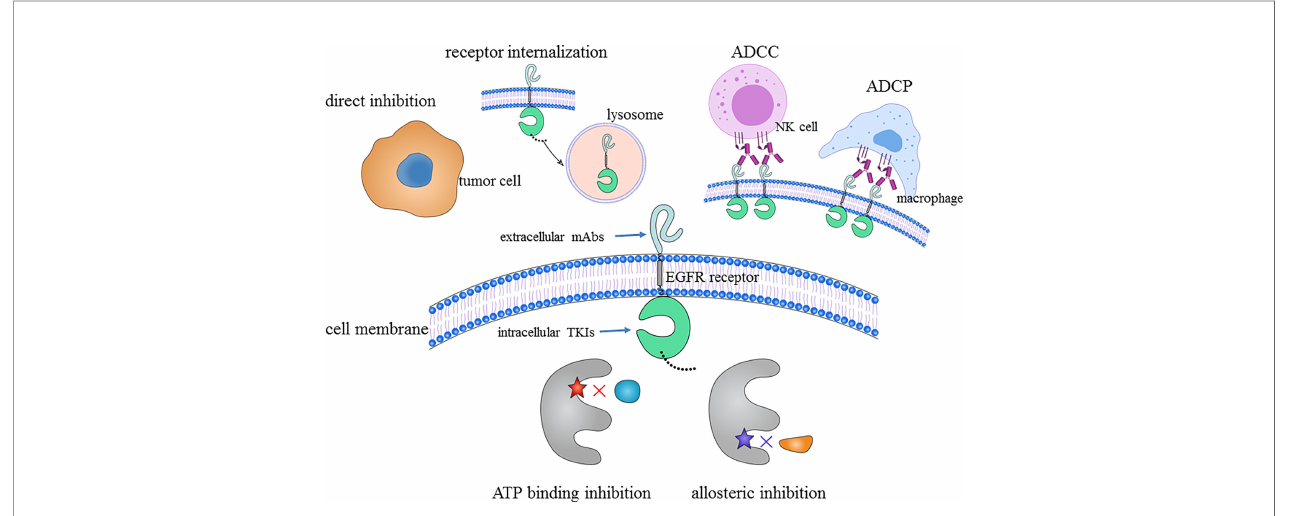
FIGURE 2 | Antitumor mechanisms of the “ sandwich ” strategy: extracellular domain targeted by EGFR mAbs and intracellular domain targeted by EGFR TKIs. ADCC, antibody-dependent cellular cytotoxicity; ADCP, antibody-dependent cellular phagocytosis; EGFR, epidermal growth factor receptor; mAb, monoclonal antibody; NK, natural killer; TKI, tyrosine kinase